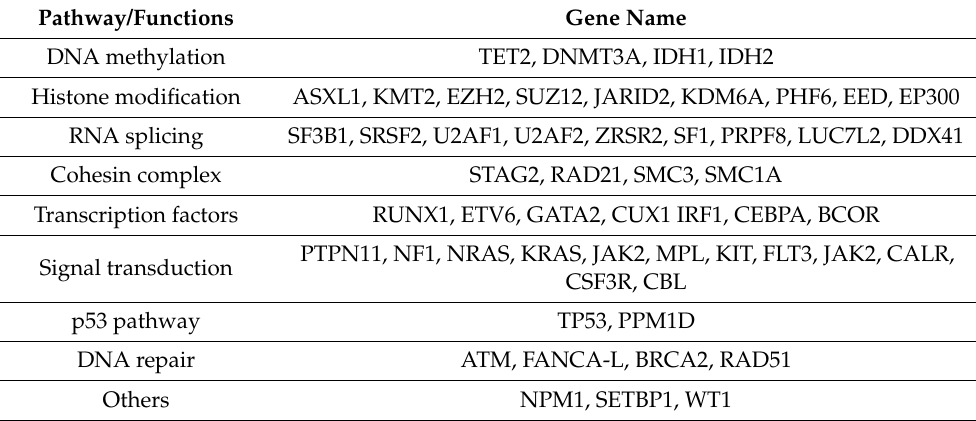
Table 1. Genes recurrently mutated in primary or secondary myelodysplastic syndromes